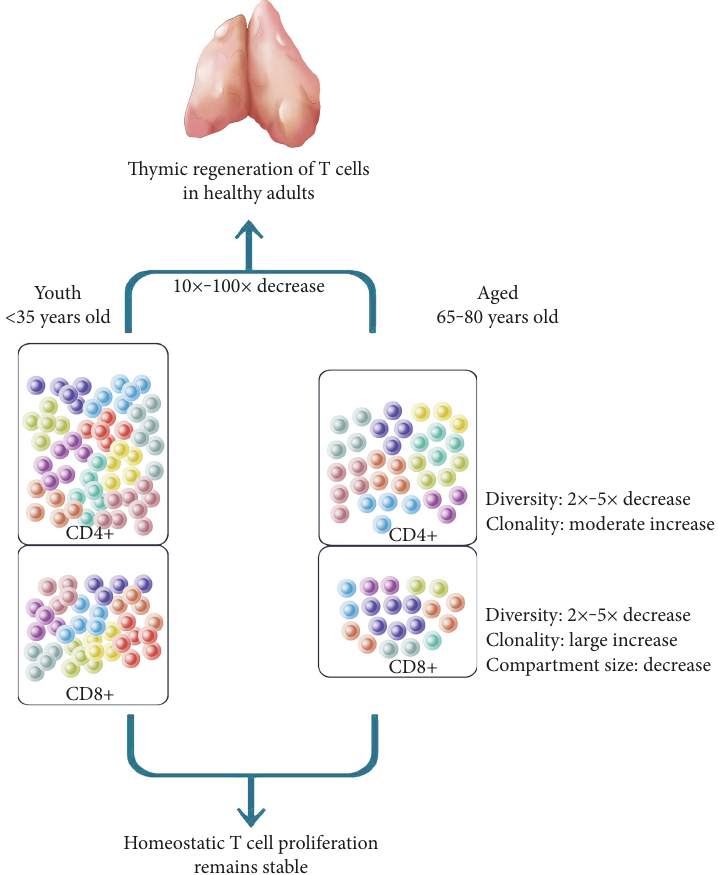
Figure 5: While thymic regeneration of T cells in healthy adults experiences a 10 – 100-fold decrease, homeostatic T cell proliferation remains stable throughout life. Both T cell lineages decrease by 2 – 5-fold in diversity. However, di ff erences in the homeostatic proliferation of CD4+ and CD8+ cells drive the imbalance of these cells observed in aging: there is a modest increase in the clonality of CD4+ cells but a large increase for CD8+ cells with a concomitant decline in the size of the CD8+